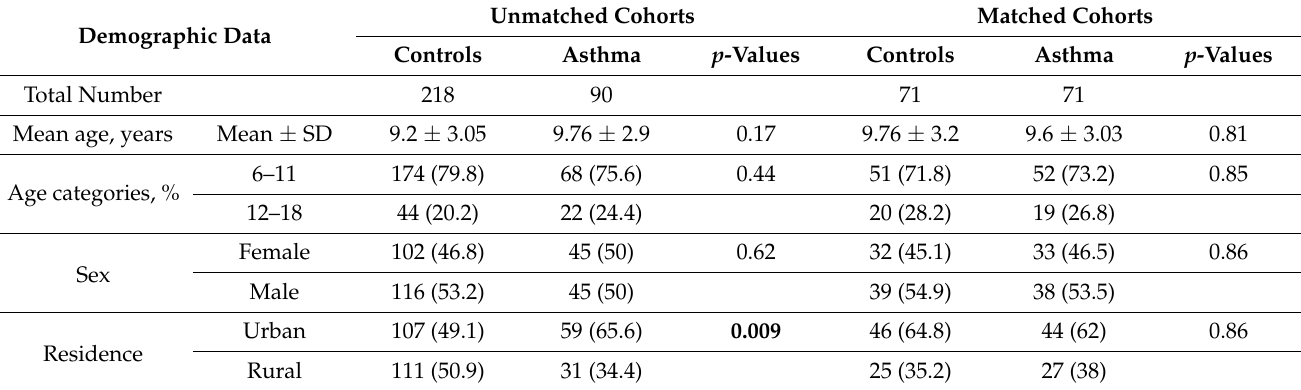
Table 1. Baseline characteristics of the study